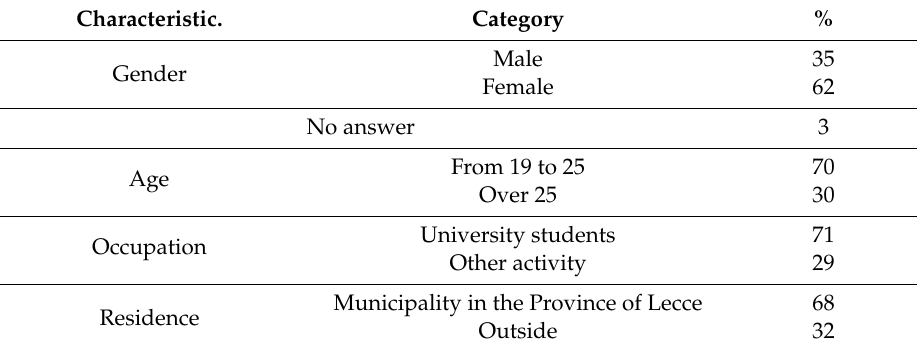
Table 1. Socio-demographic characteristics of the sample.